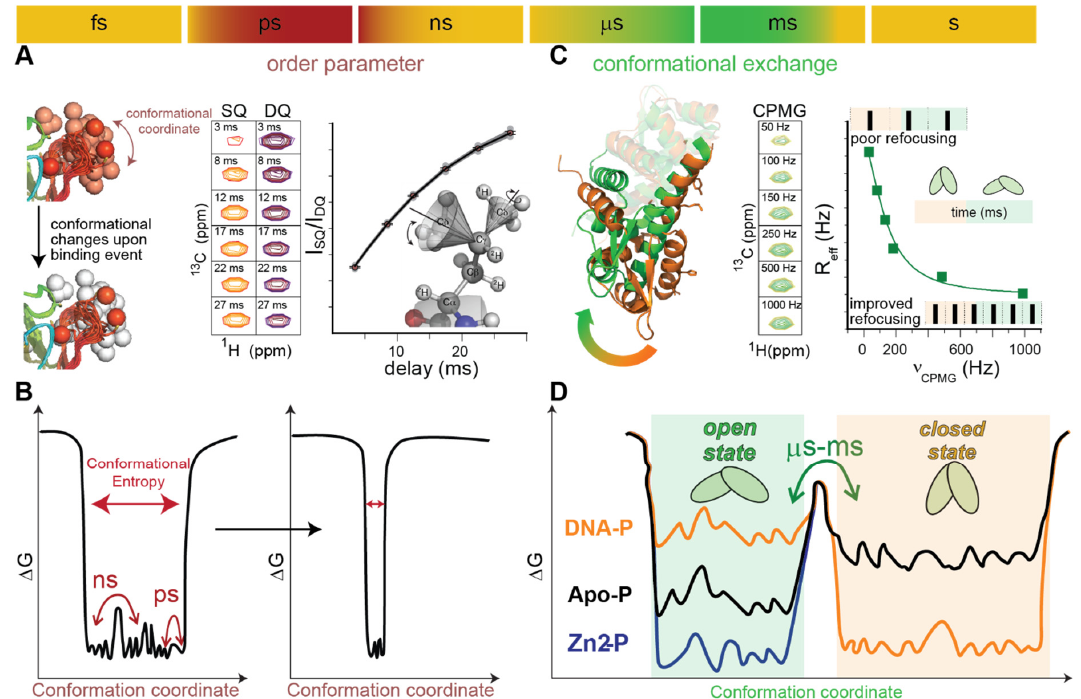
Figure 4. Time scale of the dynamic processes in proteins and the experimental methods that can determine small-amplitude conformational changes in different time scales are represented by the bar on the top. ( A ) ps–ns equilibrium dynamics (shaded red on the time scale bar and illustrated by the protein cartoon on the left) can be studied with relaxation experiments that involve NMR probes that experience forbidden transitions (double quantum, DQ, depicted by purple cross peaks at different delays) performed in parallel to the allowed (single quantum, SQ, depicted by orange cross peaks at different delays). The amplitude of these motions (illustrated by a sidechain drawing on the right panel) is reflected by order parameters obtained from the fit intensity ratio (black trace on the right panel). This ultimately allows for the estimation of conformational entropy changes upon binding, as the sidechain order parameter is a proxy for the number of conformations a protein visits in the sub-nanosecond time scale [152] (left). ( B ) Free energy diagram differences are introduced by a ligand-binding event, such as the one depicted in panel ( A ) (left), which reduces conformational entropy by decreasing the amplitude for a particular coordinate. ( C ) Micro- and millisecond time scale equilibrium dynamics (shaded green on the time scale bar and illustrated by the protein drawing on the left) can be studied with CPMG relaxation dispersion NMR experiments. If the molecule interconverts between two conformational states denoted by open (green) and closed (orange), the intensity of the cross peaks for the NMR reporters will increase their intensity when increasing the frequency of the CPMG pulse (middle panel, cross peaks in green). In these experiments, the dependence of R 2eff (proportional to -ln (intensity)) with the frequency of pulses directly reports on the degree of chemical exchange of a particular probe, as the protein visits different conformations [153]. ( D ) Free energy diagrams for an allosteric mechanism that relies on conformational selection and can be studied by CPMG based experiments; here, it is exemplified by a simplified version of the CzrA landscape [110]. Apo state shown in black, DNA-bound state shown in orange, and Zn-bound state shown in blue. The apoprotein can visit open and closed conformations in the µs–ms scale, while DNA binding selects the closed conformation, and the allosteric inhibitor selects the DNA incompatible conformation. All the spectra are exemplified with methyl sidechains as reporters, as these are particularly well suited for TR DNA complexes based on their increased sensitivity [153].